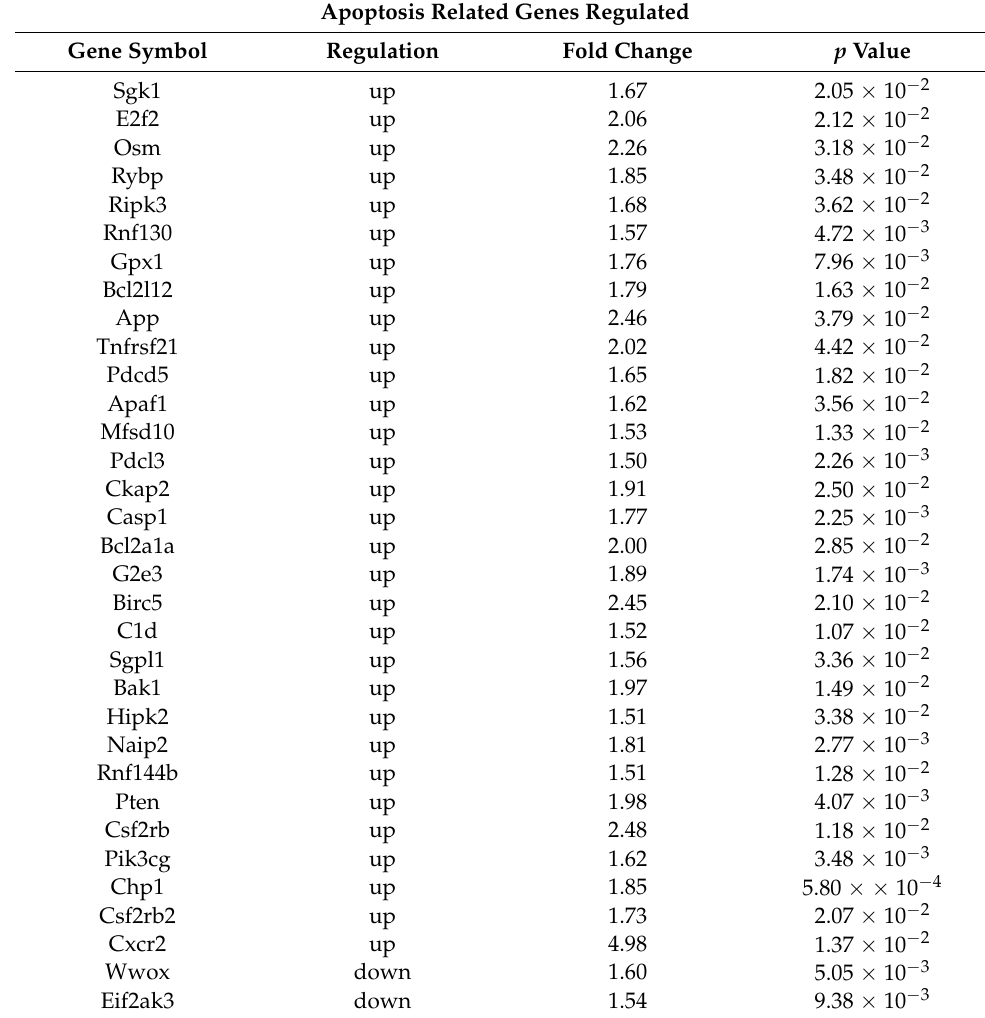
Table 1. Target genes regulated after ABT-737 of HR-MDS mice. Fold change of treated compared to untreated mice was considered significant when ≥ 1.5 and p -value ≤ 0.05. The arrays were normalized to FVB/N, and the treated HR-MDS group was compared to the untreated